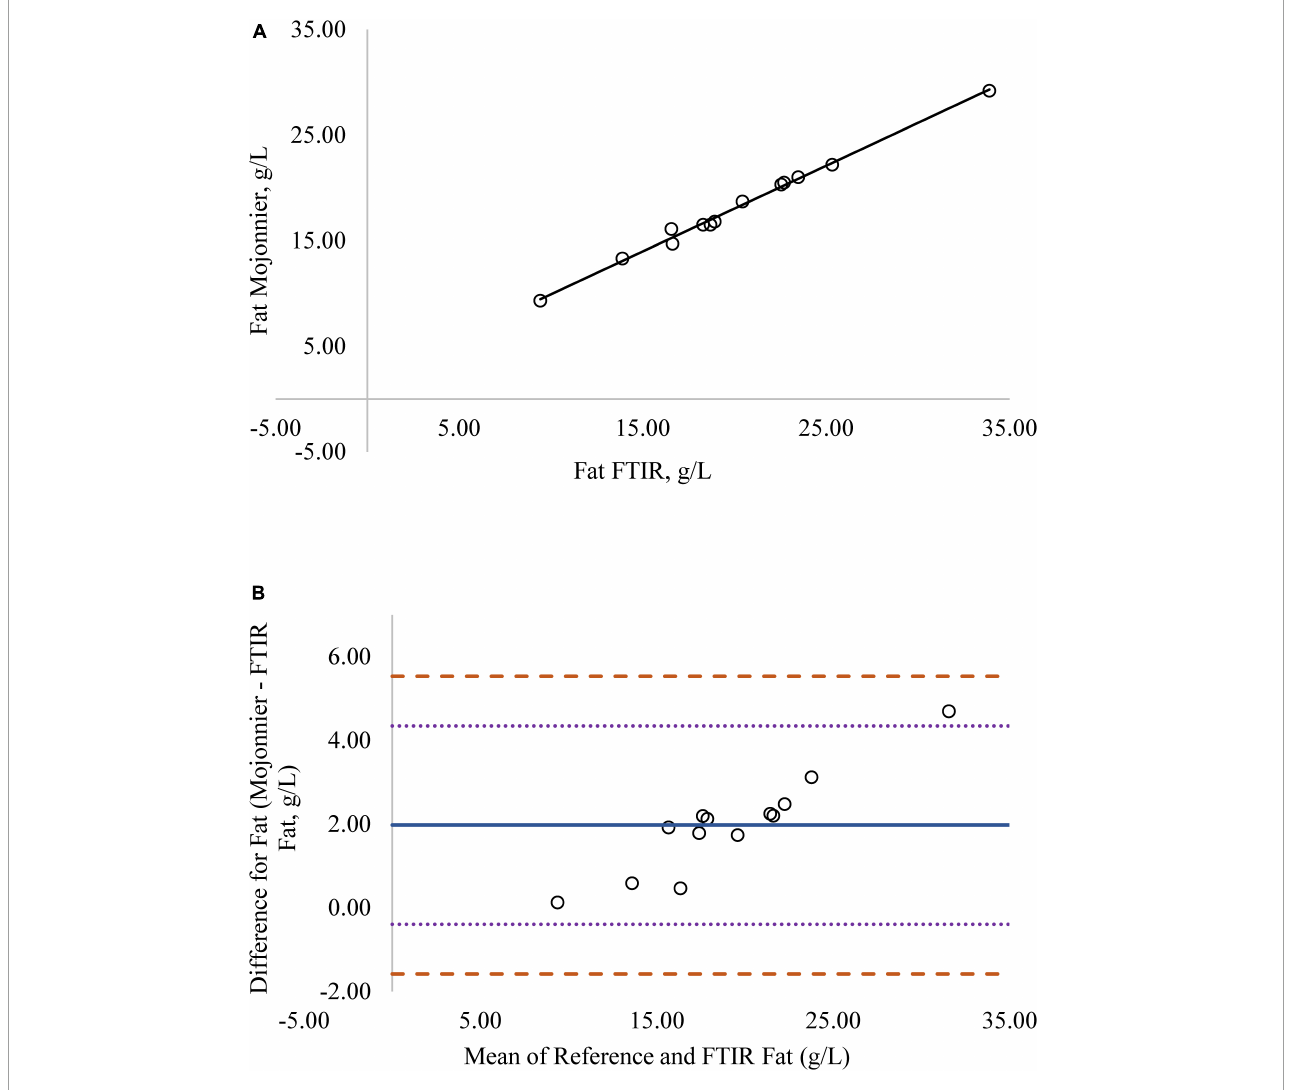
FIGURE2 (A) Mare milk fat concentration measured by FTIR and the reference Mojonnier method. Correlation graph between the two methods for fat, r 2 = 0.99, P < 0.0001. Regression model y = 0.812X + 0.180. (B) Mare milk fat concentration measured by FTIR and Mojonnier method. Bland-Altman plot showing the mean differences and limits of agreement. Bias line: solid line, two standard deviation (s.d.): dotted lines, three s.d.: dashed